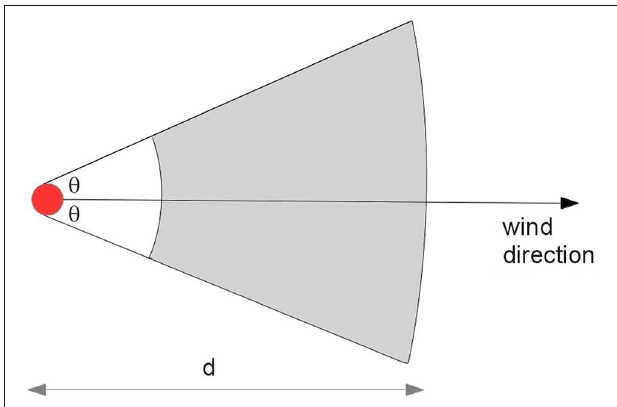
FIGURE 4 | Downwind extent of airborne spread for an infected pig